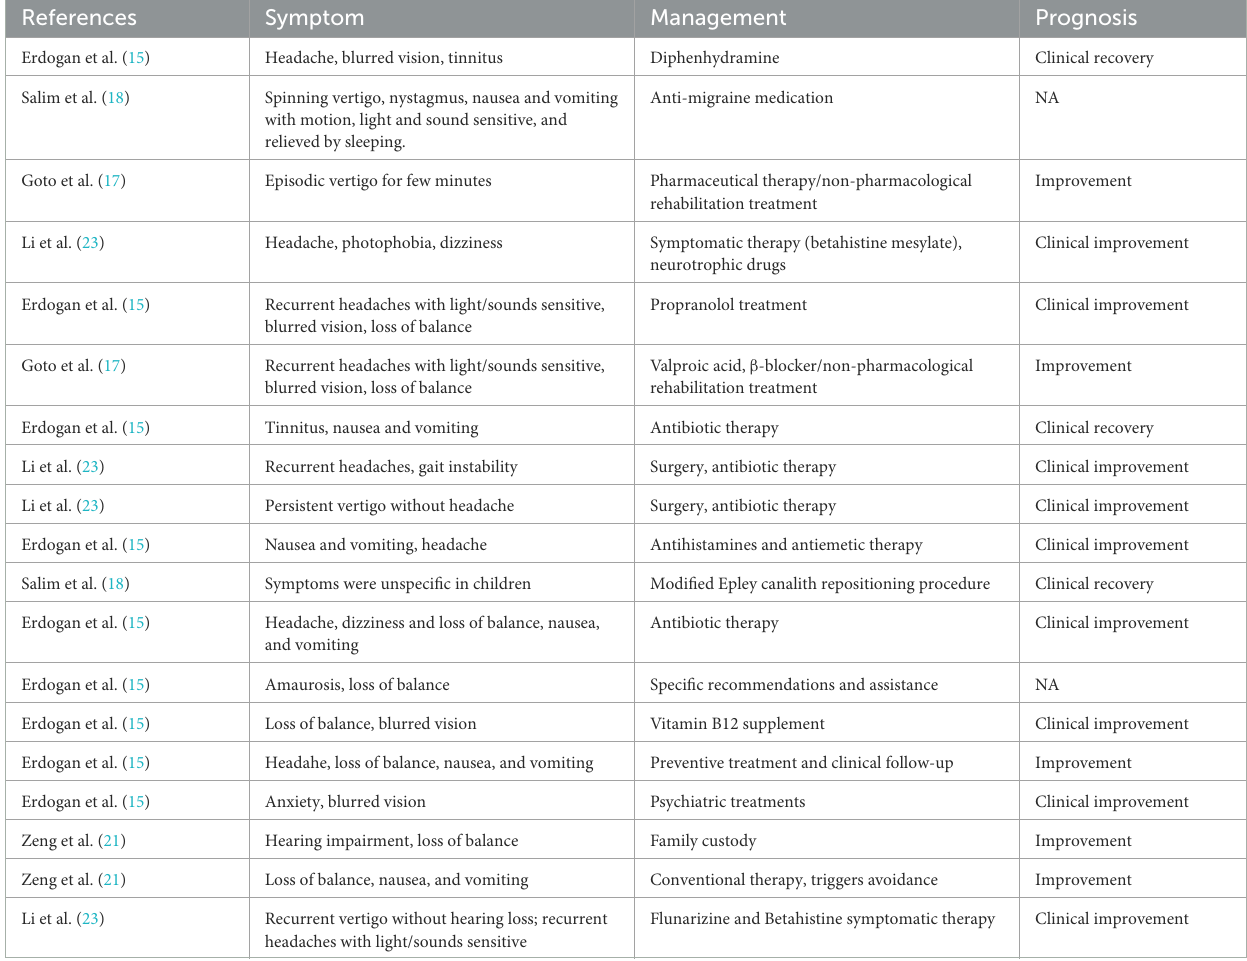
TABLE 8 Information of management and prognosis in studies